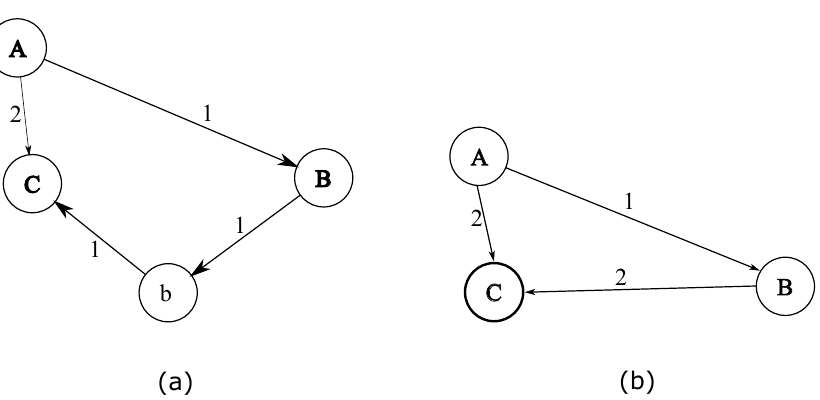
Figure 10. Key function call graph, ( a ) remove non-key function a; ( b ) remove non-key function